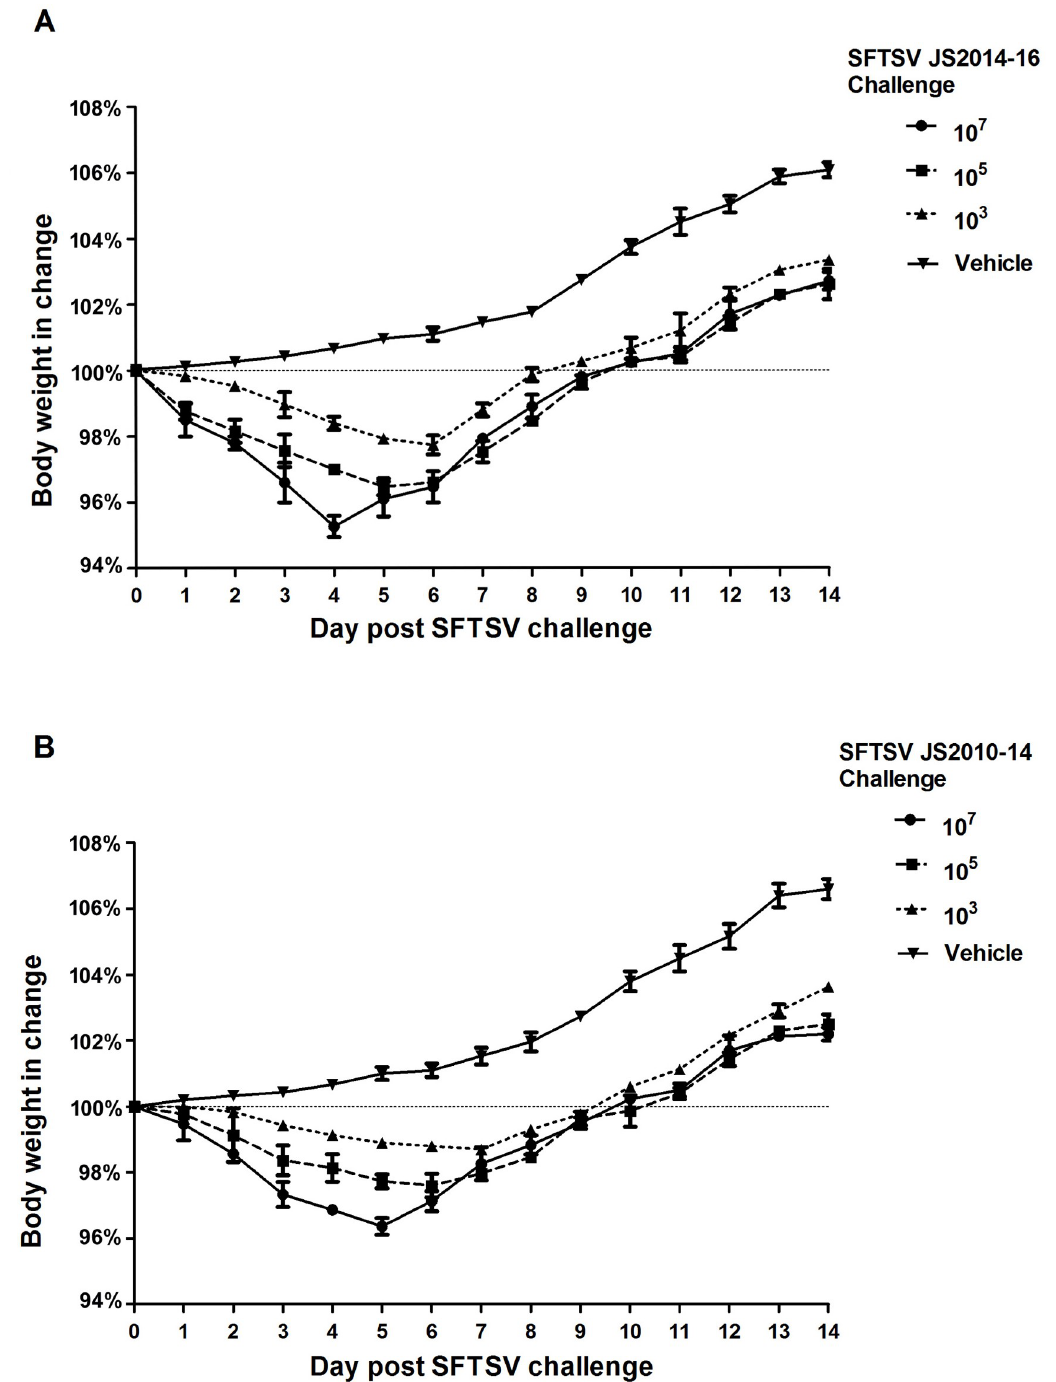
Fig 4. Change in body mass of the spotted doves following SFTSV challenge. Mean changes in body mass and standard error bars are plotted at daily intervals following challenge of the spotted doves. Changes in body mass following SFTSV challenge showed a dose and strain dependent response. Birds challenged with 10 7 plaque-forming units (PFU) of SFTSV strain JS2014 had earlier and greater losses of body mass than did birds challenged with 10 5 or 10 3 PFU of the same SFTSV strain. Birds challenged with SFTSV strain JS2014 had greater losses of body mass than the birds challenged with same dose level of SFTSV strain JS2010.